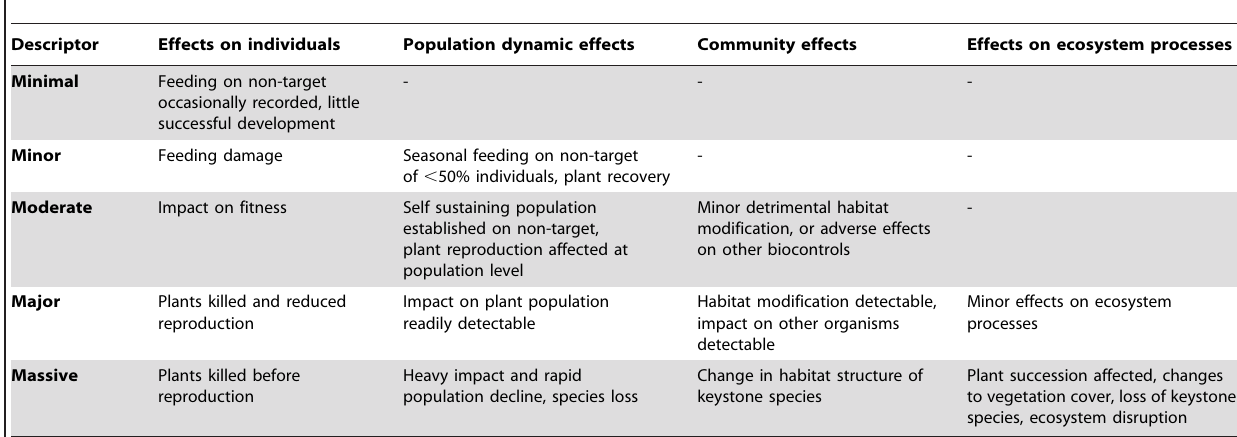
Table 2. Proposed scale for retrospectively assessing the magnitude of adverse environmental effects from biological control